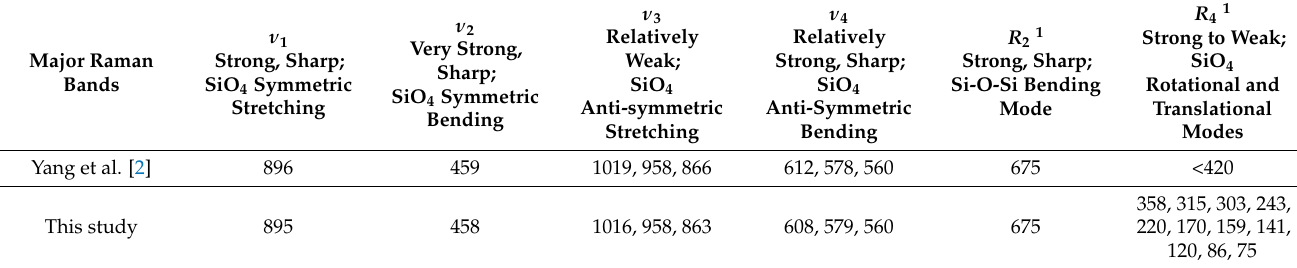
Table 1. Major Raman bands for scottyite on a previous experiment study and on this Raman spectroscopic study.